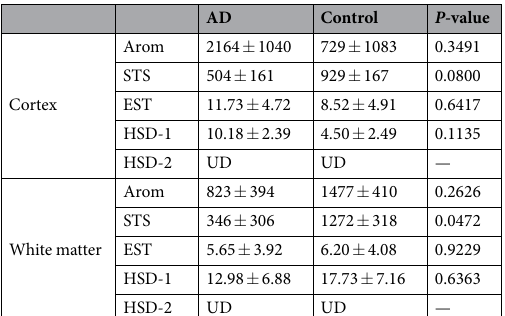
Cortex — Arom 823 ± 394 1477 ± 410 0.2626 STS White matter — Table 4. Comparison of mRNA level for each estrogen metabolizing enzyme in the cortex and white matter of the frontal lobe between Alzheimer’s disease and control groups. AD, Alzheimer’s disease; Arom, aromatase; STS, steroid sulfatase; EST, estrone sulfotransferase; HSD-1, 17 β -hydroxysteroid dehydrogenase type 1; HSD-2, 17 β -hydroxysteroid dehydrogenase type 2; UD,